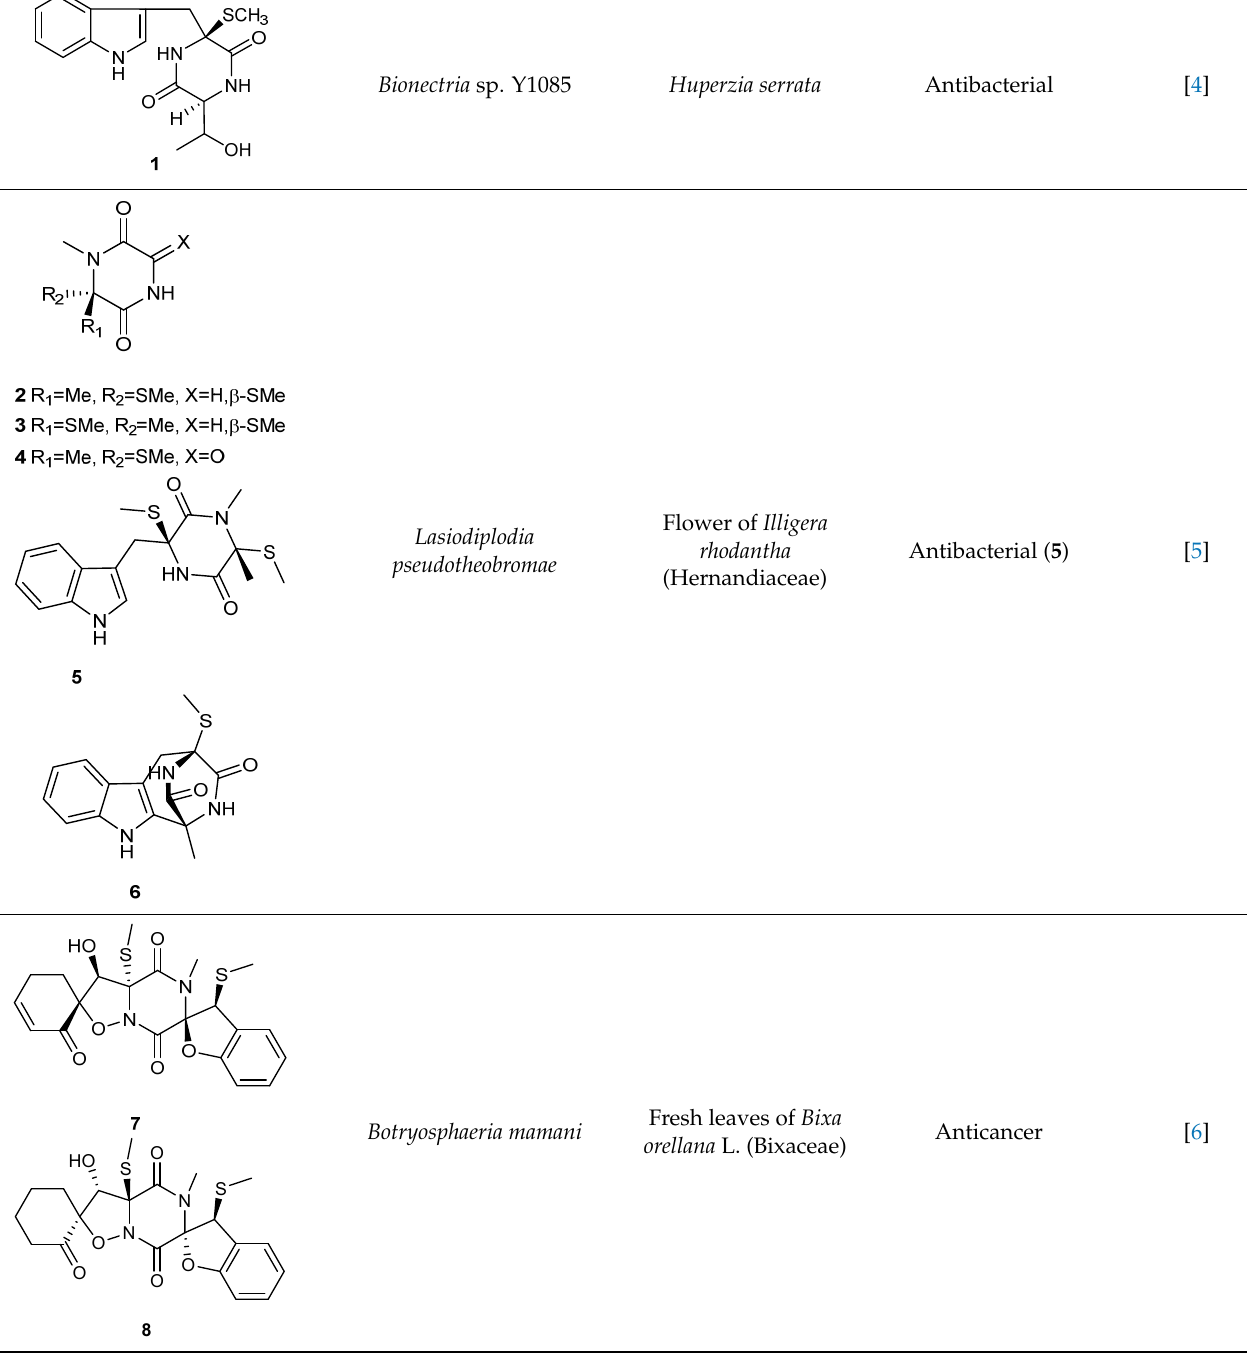
Table 1. Sulfur-containing compounds isolated from plant endophyte fungi. Compound Structures